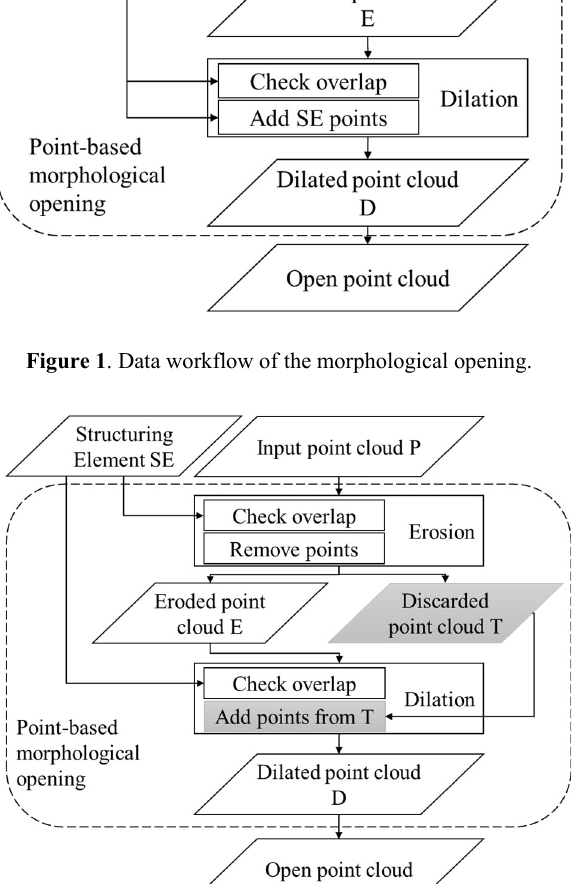
Figure 2 . Data workflow morphological opening with input data retrieval.